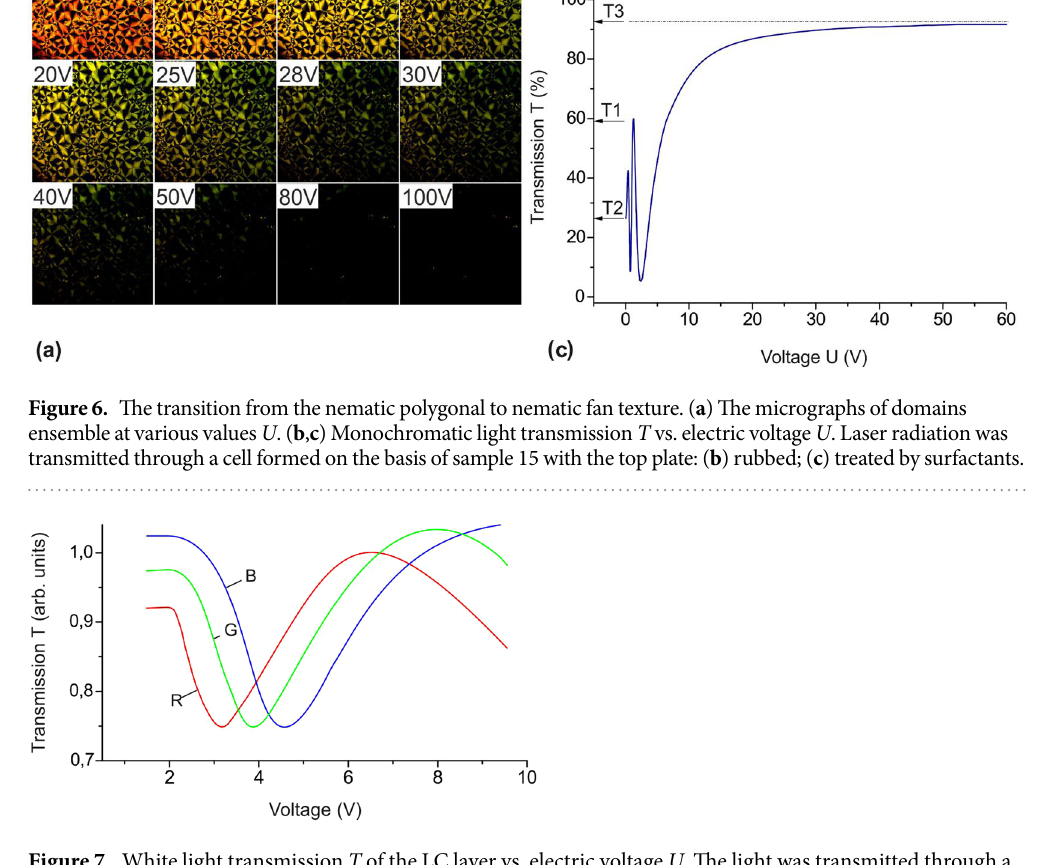
Figure 7 shows the tricolor characteristics of transmittance of cell A as a function of electric field. To obtain these characteristics, the cell was places between crossed polarizers and illuminated by normally incident white light transmitted through a red (R), green (G), or blue (B) filter with wavelengths of λ (R) = 700, λ (G) = 520, and λ (B) = 452 nm, respectively. It can be seen in Fig. 7 that there is a potential difference between extrema of curves R, G, and B, which is comparable with the differences obtained for hybrid-aligned nematic cells 20 or cells with color filters 21 used in multicolor LC displays.